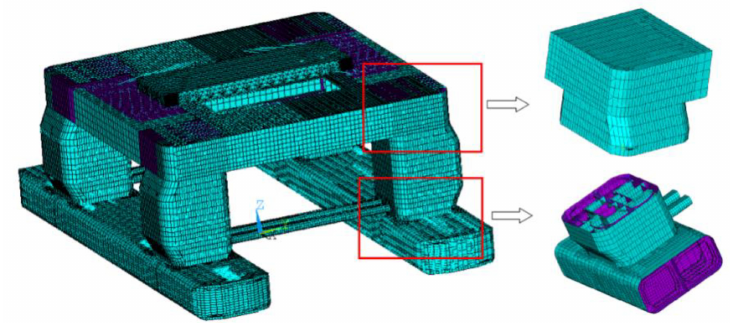
Figure 9. Main nodes of the object